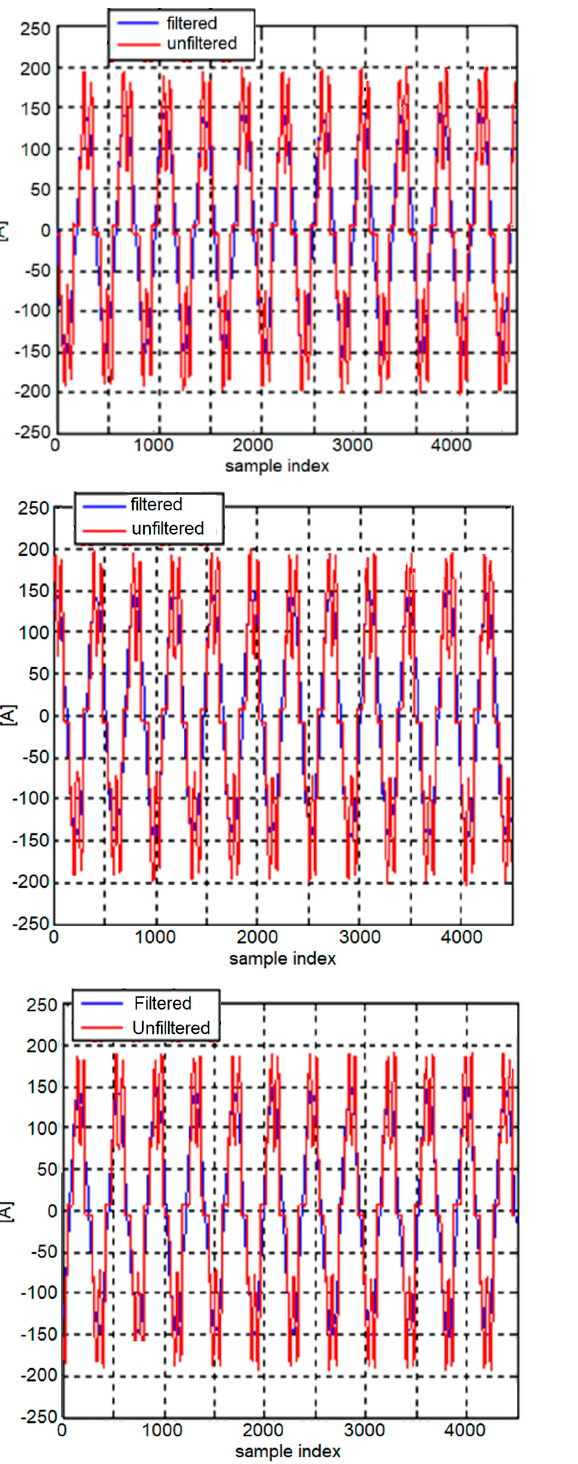
Figure 16. Case β (RMS of phase currents equal to 132 A per phase). From top to bottom: phase 1, phase 2, and phase 3. ( Left ) Unfiltered phase currents (red) overlapped with filtered currents (blue). ( Right ) Difference between filtered and unfiltered currents.